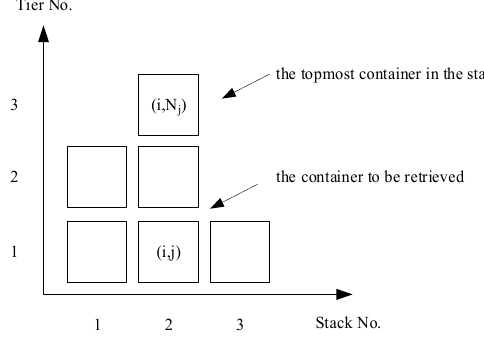
Figure 7. Container storage layout of a bay in the yard.